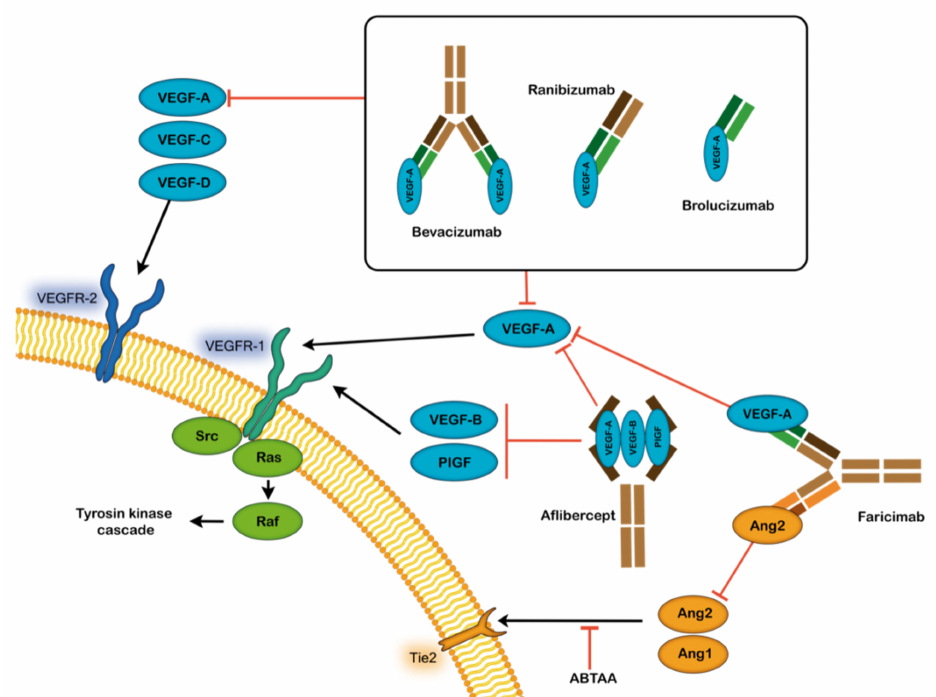
Figure 2. Summary of the currently available anti-VEGF treatments for neovascular age-related macular degeneration: bevacizumab (off-label), ranibizumab, brolucizumab, faricimab and afliber- cept. VEGF-A, B, C and D: Vascular endothelial growth factor A, B, C and D; VEGFR-1 and 2: Vascular endothelial growth factor receptors 1 and 2; PlGF: Placental growth factor; Ang 1 and 2: Angiopoietin 1 and